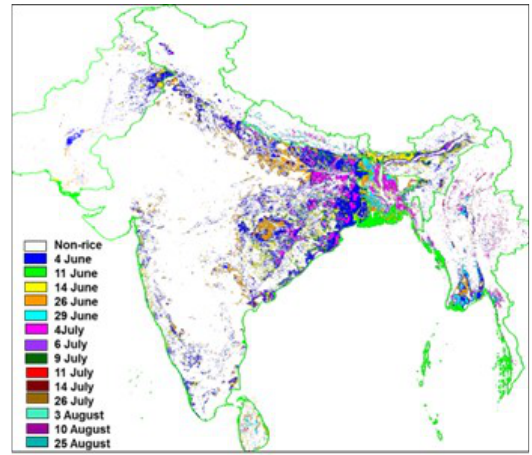
Figure 4. Planting date of rice in six South Asian countries